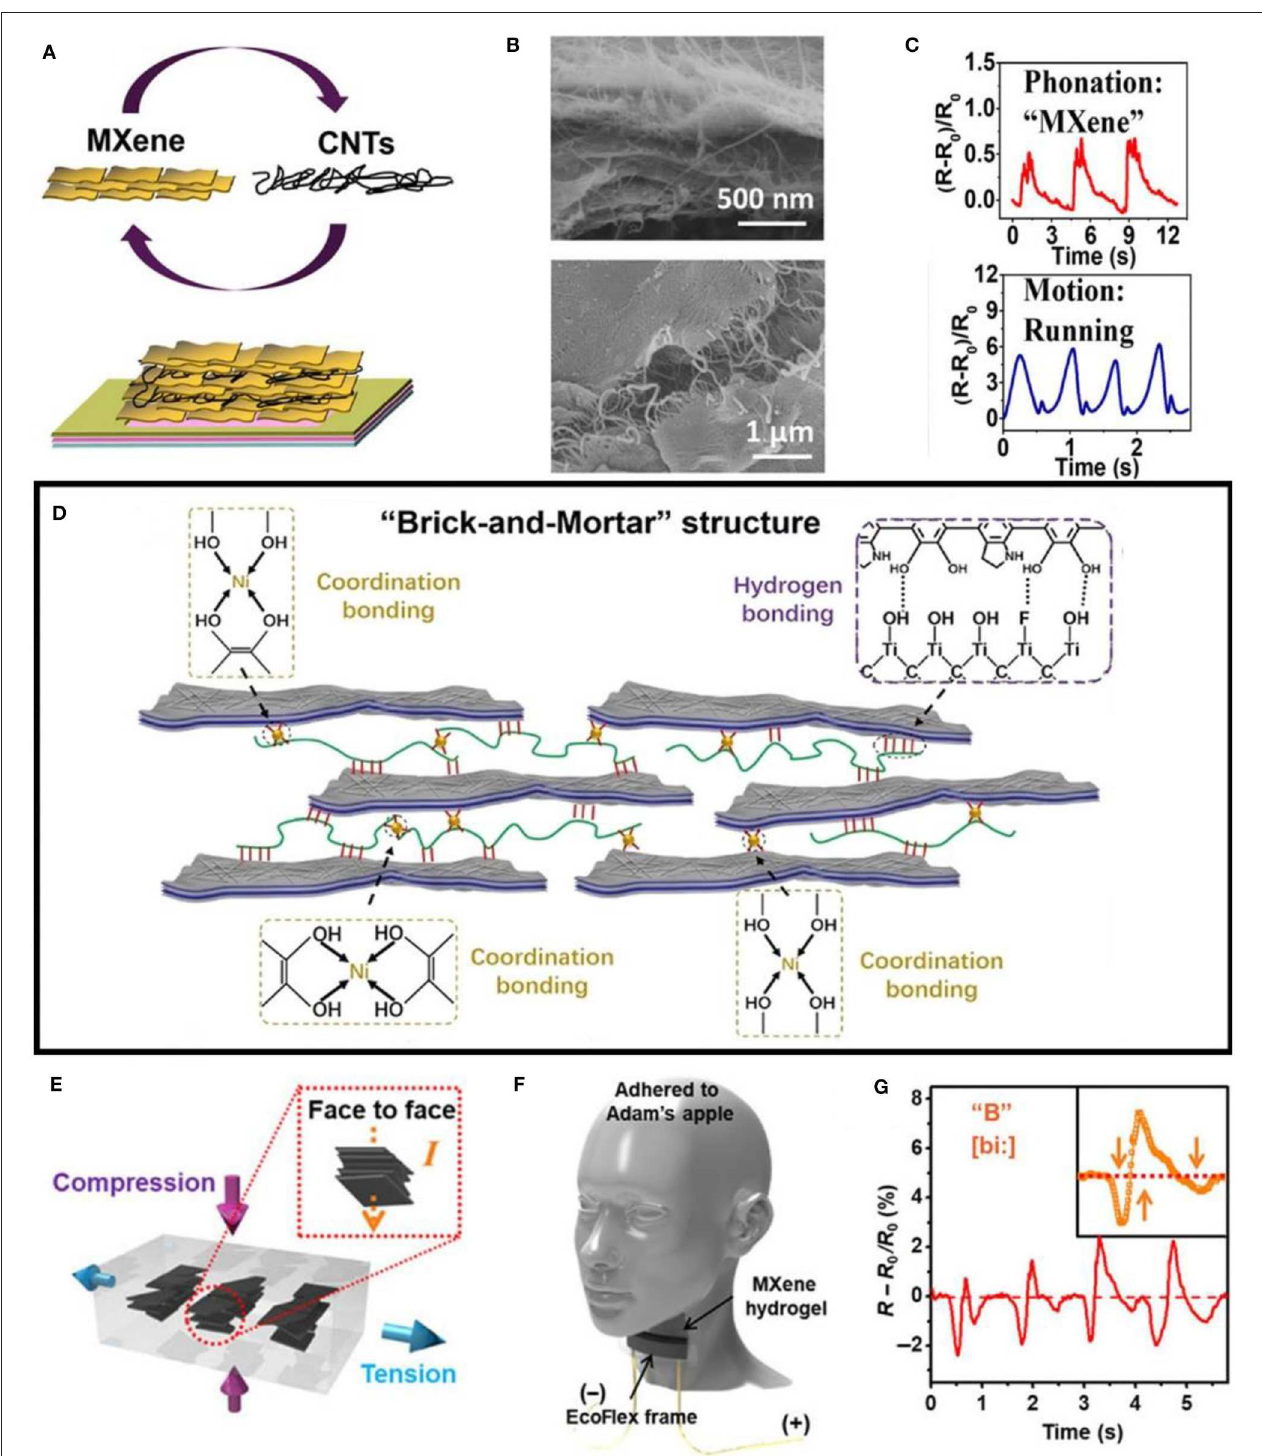
FIGURE 3 | MXenes for strain sensor. (A) Fabrication process of a sandwich-like Ti 3 C 2 T x MXene/CNT layer; (B) SEM images of sandwich-like Ti 3 C 2 T x MXene/CNT layers. (C) Relative resistance responses of the sensor in phonation and motion; (A–C) are reproduced from Cai et al. (2018) with permission from American Chemical Society. (D) Schematic illustration of the Ti 3 C 2 T x -AgNW-PDA/Ni 2 + sensor based on the “brick-and-mortar” architecture; reproduced from Shi et al. (2019) with permission from American Chemical Society. (E) Schematic illustration of the mechanism of the electromechanical responses of M-hydrogel; (F) Schematic for vocal sensing and (G) Resistance change in response to similarly sounding letters “B.” (E–G) are reproduced from Zhang et al. (2018).